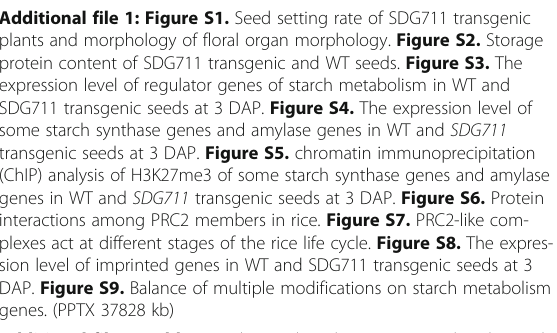
Additional file 1: Figure S1. Seed setting rate of SDG711 transgenic plants and morphology of floral organ morphology. Figure S2. Storage protein content of SDG711 transgenic and WT seeds. Figure S3. The expression level of regulator genes of starch metabolism in WT and SDG711 transgenic seeds at 3 DAP. Figure S4. The expression level of some starch synthase genes and amylase genes in WT and SDG711 transgenic seeds at 3 DAP. Figure S5. chromatin immunoprecipitation (ChIP) analysis of H3K27me3 of some starch synthase genes and amylase genes in WT and SDG711 transgenic seeds at 3 DAP. Figure S6. Protein interactions among PRC2 members in rice. Figure S7. PRC2-like com- plexes act at different stages of the rice life cycle. Figure S8. The expres- sion level of imprinted genes in WT and SDG711 transgenic seeds at 3 DAP. Figure S9. Balance of multiple modifications on starch metabolism genes. (PPTX 37828 kb) Additional file 2: Table S1. Oligonucleotides primers used in the